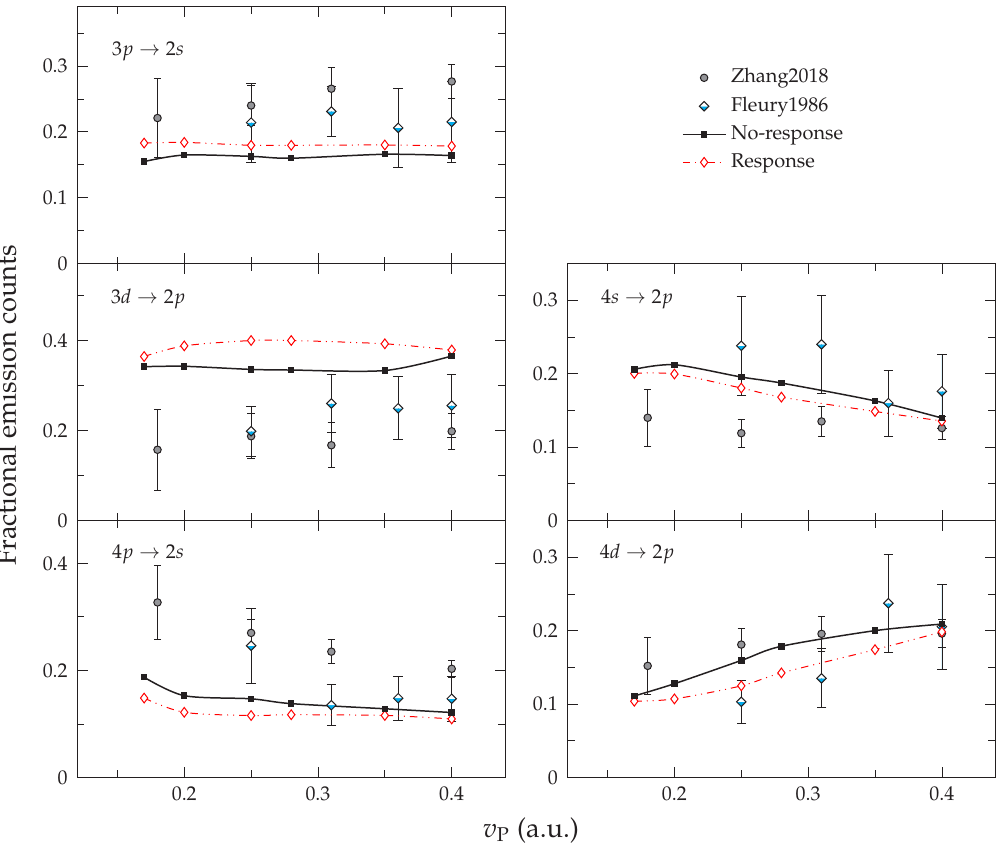
Figure 3. Fractions of line emissions with respect to impact speed from charge-exchange Ne 8+ –He collisions. Experiments: Zhang et al. [20,21]; Fleury et al. [16]. Theory: present